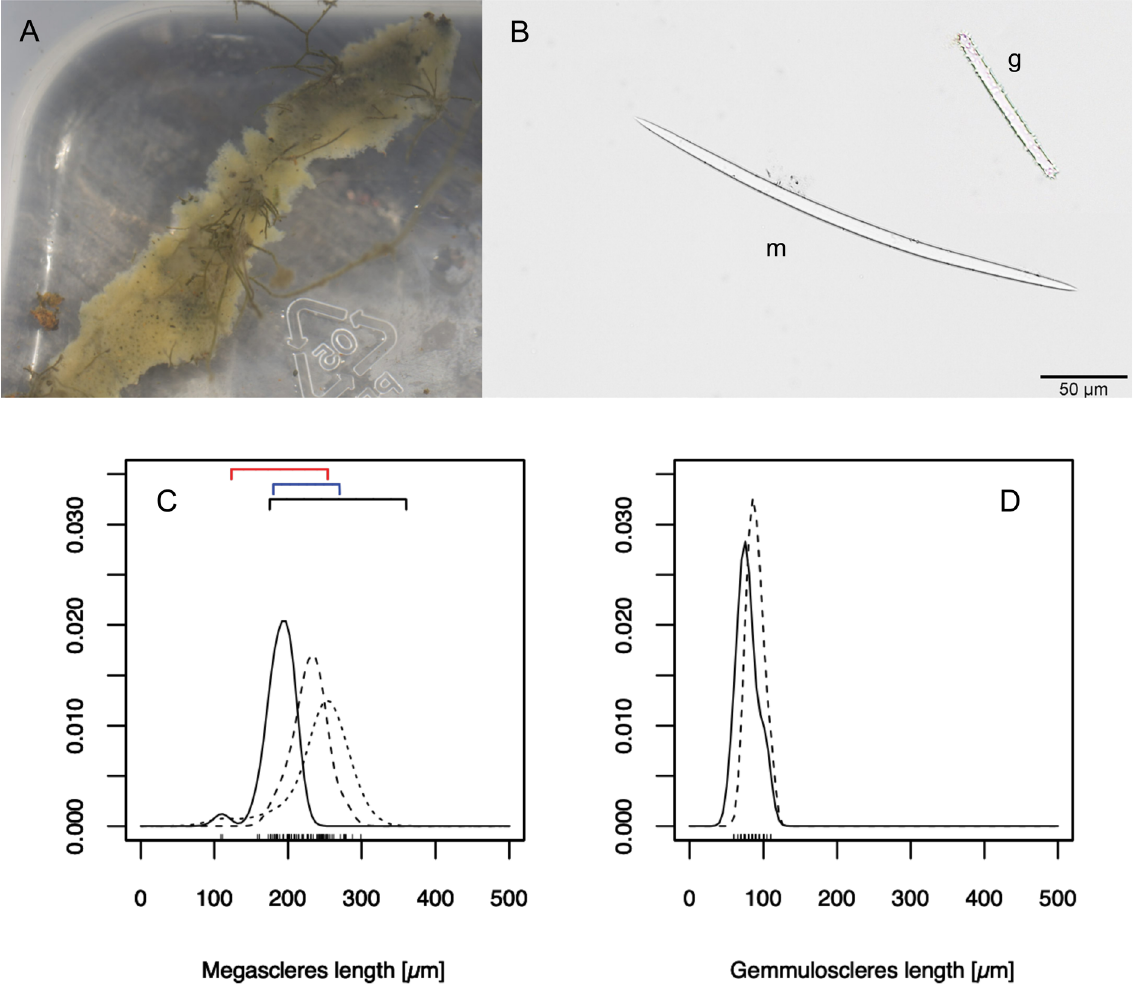
Fig. 5. Eunapius fragilis (Leidy, 1851) . A . Habitus (P059-170829-4). B . Spiculae, m = megasclere (P059-170830-13), g = gemmulosclere (P059-170902-1). C–D . Estimated spicula size distribution within and between specimens, P059-170802-10 (solid line), P059-170830-2 (dashed) and P059-170830- 4 (dotted). Marks on the x-axis represent spiculae measured. C . Megascleres. Brackets correspond to ranges in literature (red = Tendal 1967b; blue = Penney & Racek 1968; black = Evans & Montagnes 2019). D .